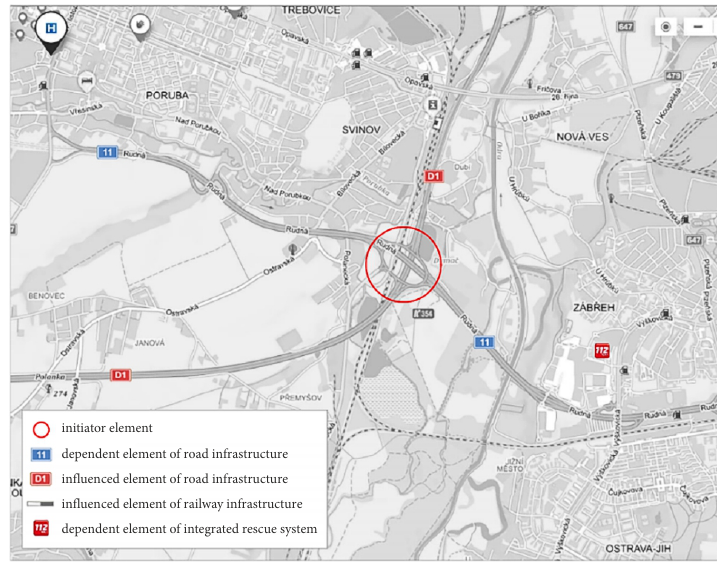
Figure 5. The selected elements plotted on a map